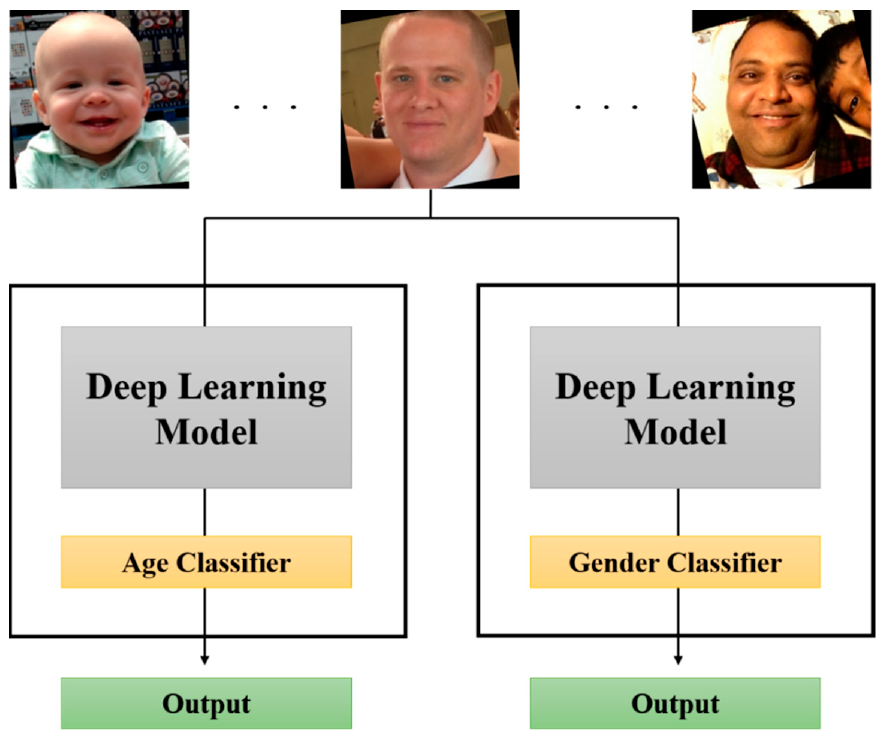
Figure 1. Multi model architecture of age and gender classification.